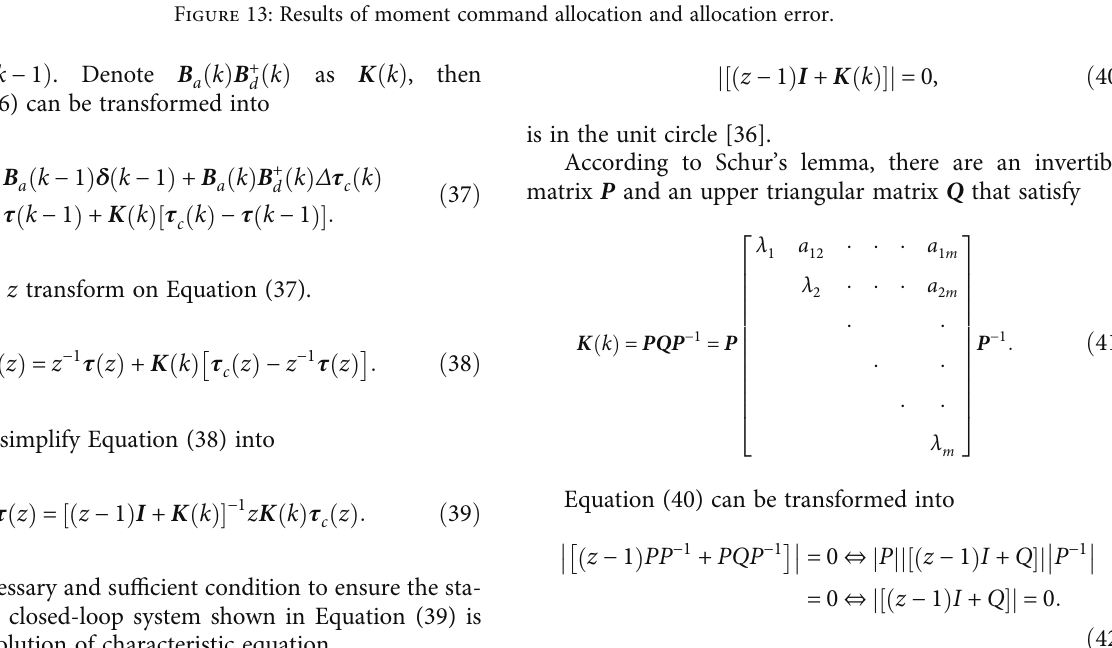
Figure 13: Results of moment command allocation and allocation